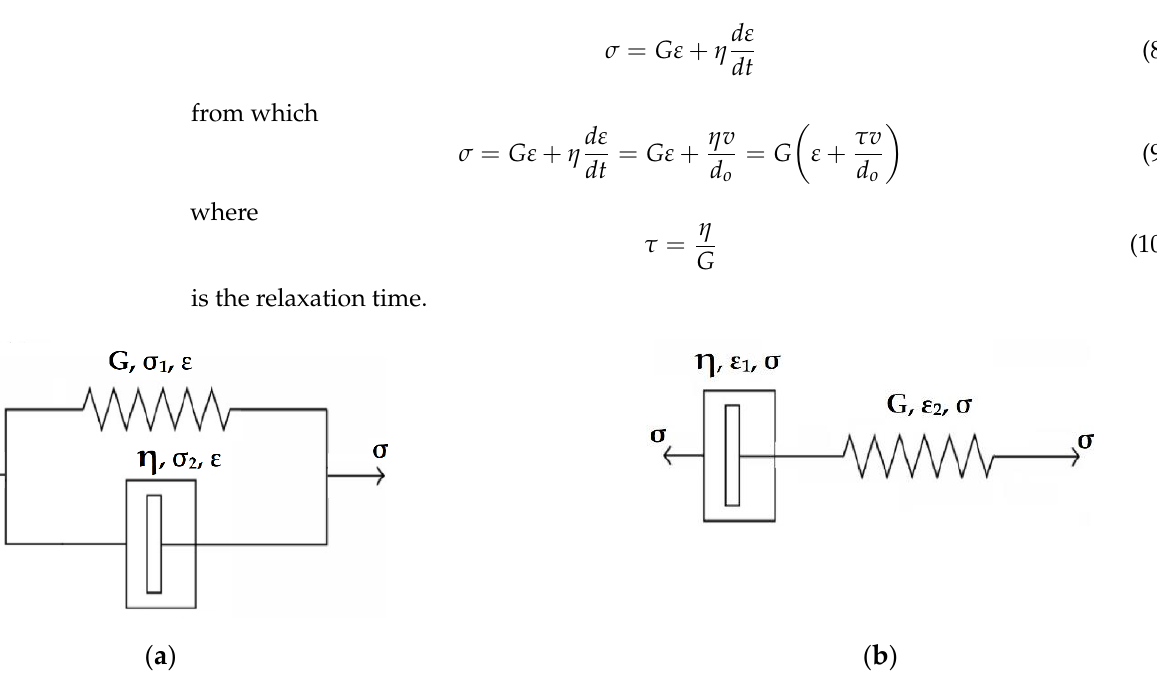
Figure 6. Linear viscoelastic models: ( a ) Voigt model; ( b ) Maxwell model.